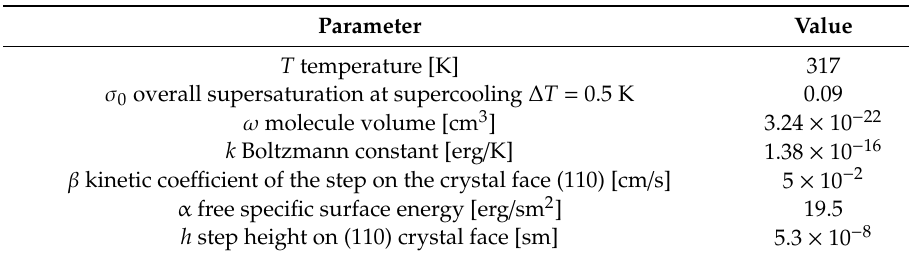
Table 2. Parameters for the crystal growth rate